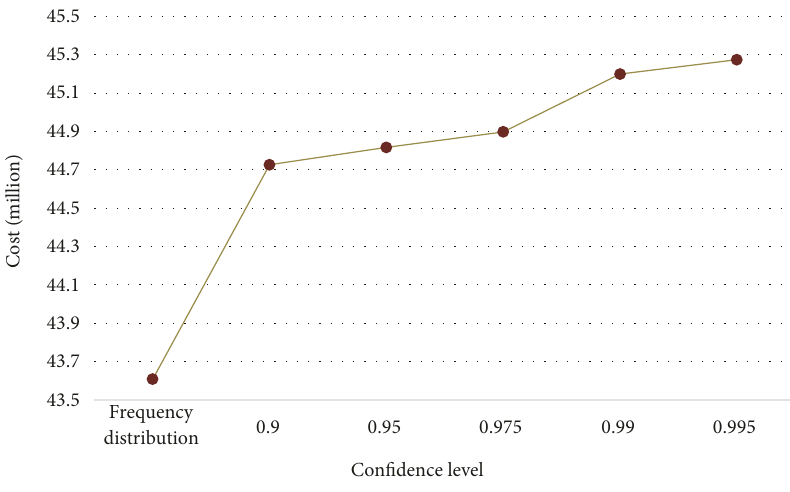
Figure 12: Expected total cost of labor employment under di ff erent con fi dence